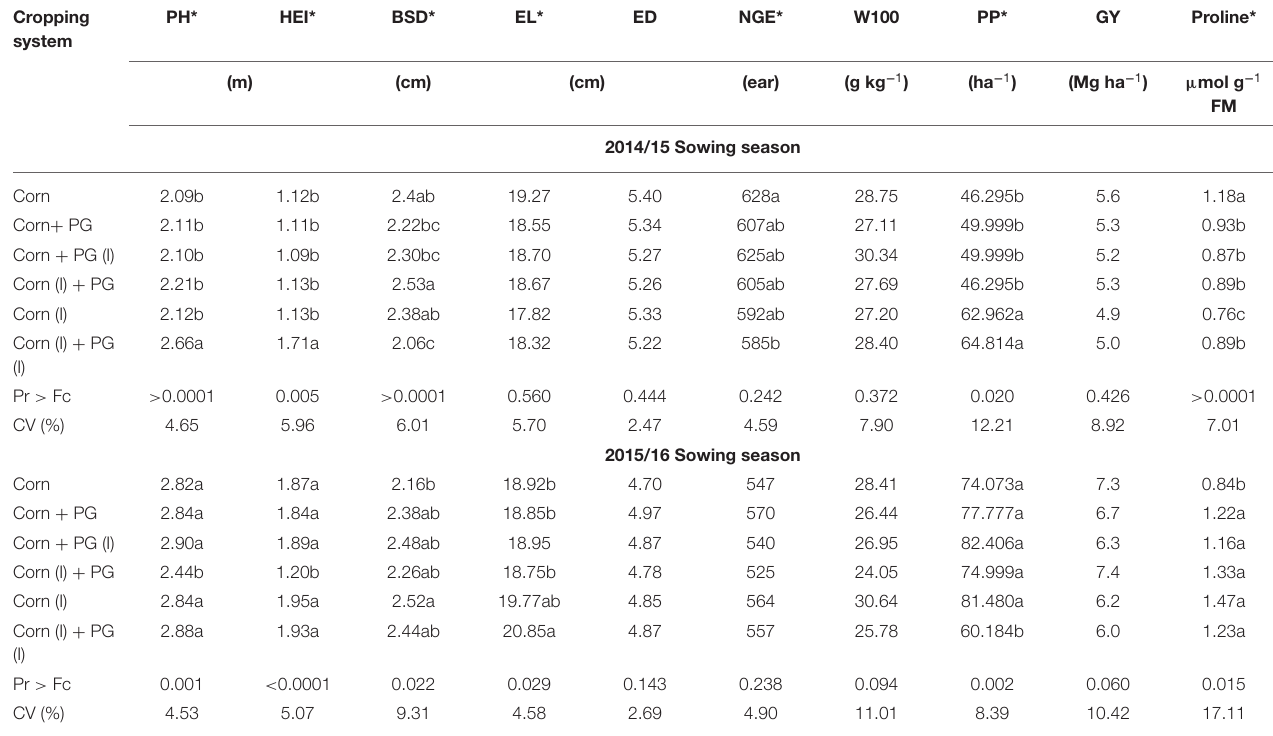
TABLE 3 | Means of plant height (PH), height of ear insertion (HEI), basal steam diameter (BSD), ear diameter (DE), ear length (EL), number of grains per ear (NGE), 100-seed weight (W100), plant population (PP) grain yield (GY) and proline content in intercropped or single corn, A. brasilense (irrigated area) inoculated or not in the seeds in 2014/15 and 2015/16